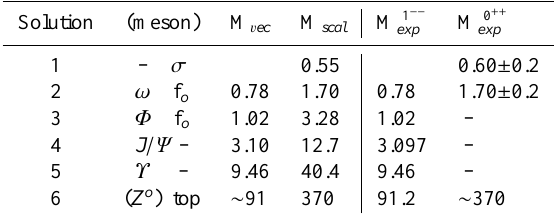
Table 1. Deduced masses (in GeV) of scalar and vector q + q − states compared to the lowest 0 ++ and 1 −− mesonic systems [2].